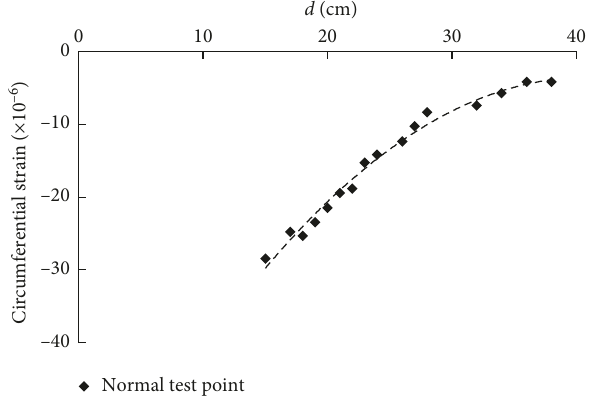
Figure 13: Top surface circumferential strain of the AC model after removing the abnormal